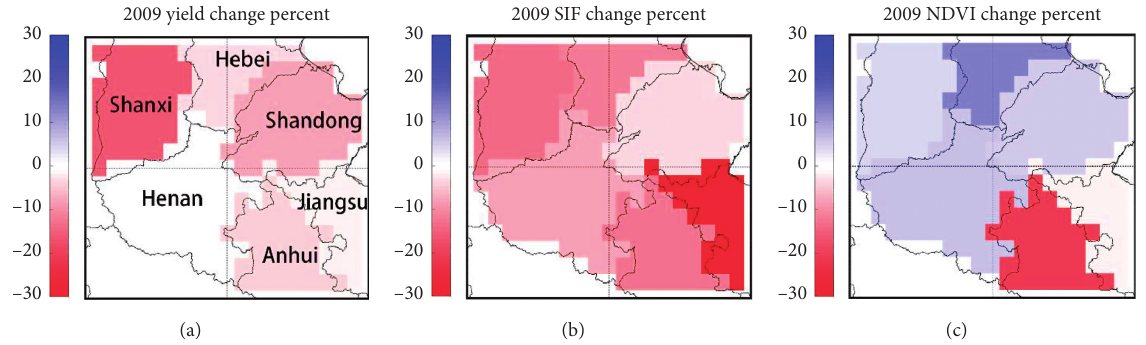
Figure 9: Spatial distributions of the 2009 change percentages (compared with multiyear values) during the time period 2008–2014 of (a) wheat yield, (b) wheat growing season mean SIF, and (c) wheat growing season mean NDVI. The location of each province is shown in (a), and panels (b) and (c) are the same as panel